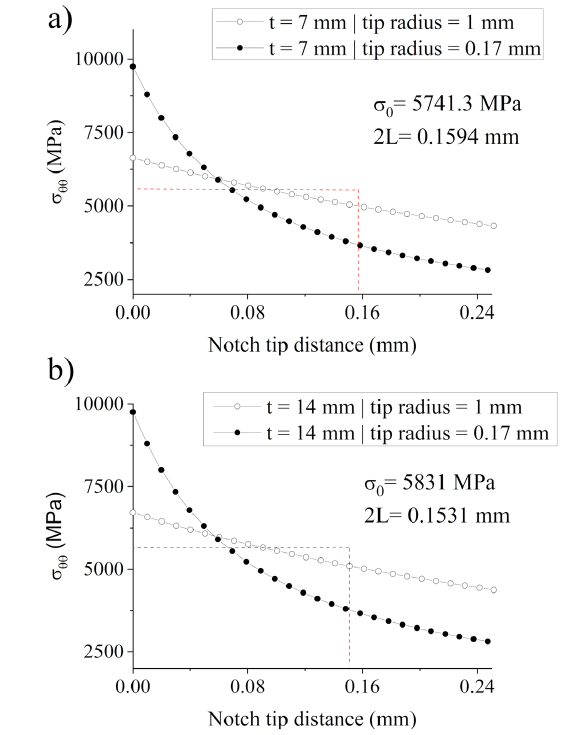
Figure 13. Stress field analysis according to LM: (a) thickness of 7 mm and (b) thickness of 14